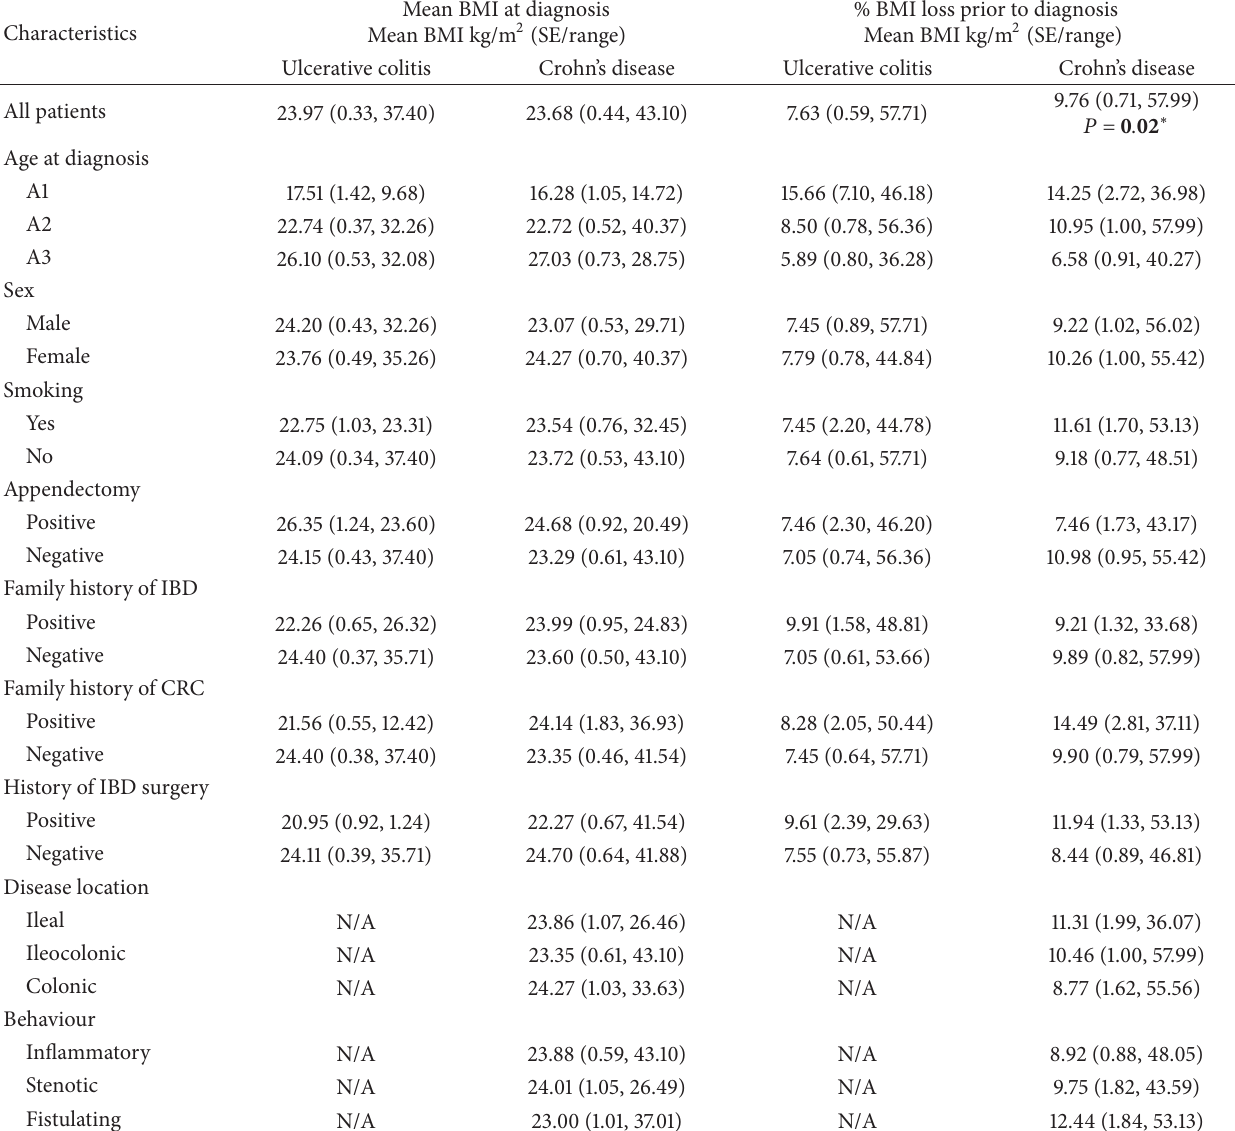
Table 2: Mean BMI at diagnosis and % of BMI loss prior to